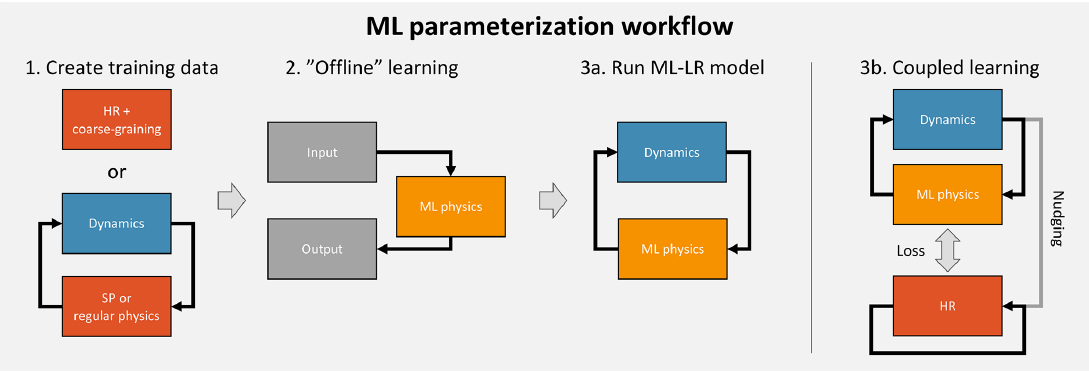
Figure 1. Schematic overview of ML parameterization workflow with and without coupled online